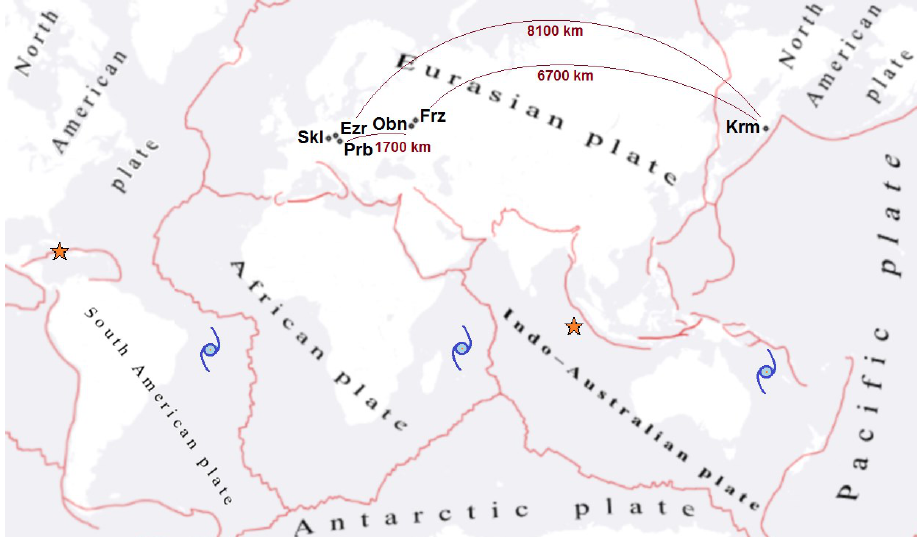
Fig. 1. Location of strain and tilt observation points: “Karymshina” KRM, “Fryazino” FRZ, “Obninsk” OBN, “Pribram” PRB, “Jezeri” JZR and “Skalna” SKL; earthquakes and tropical cyclones.